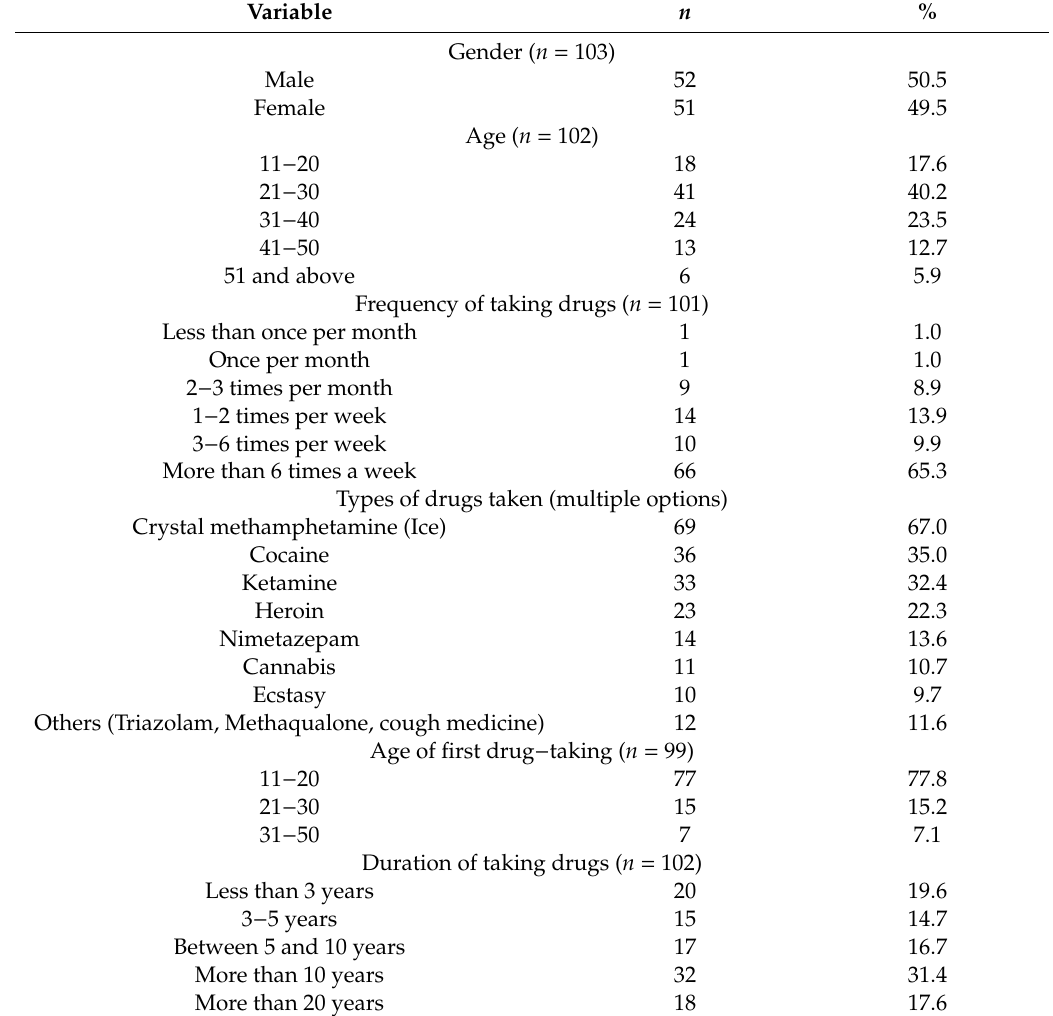
Table 1. Demographic and drug use data of